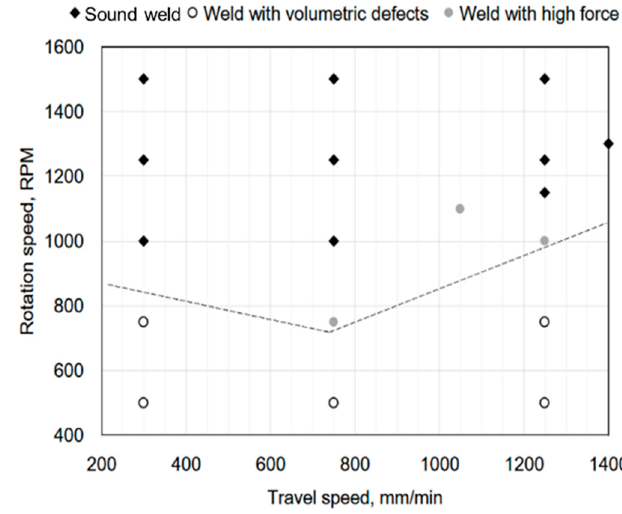
Figure 4. Process window of joint formation.